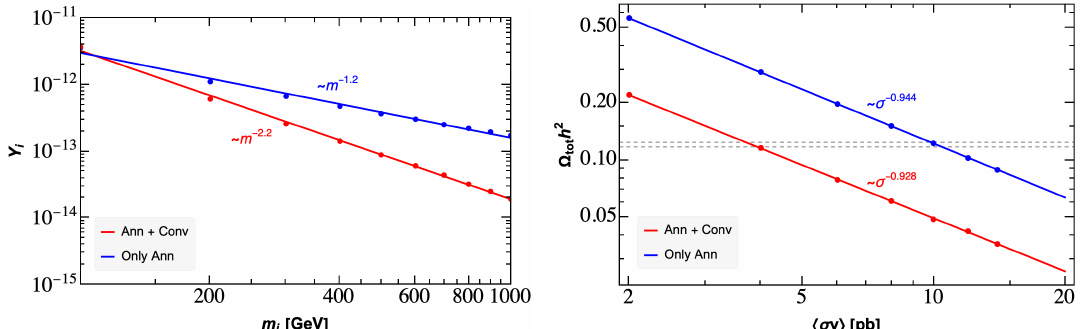
Figure 2 . Power-law fits for the yields (left panel) and total abundance (right panel) in the symmetric case for 10 DM particles with equal annihilation and conversion cross section, h σv i . Left panel: individual yields versus DM mass; we choose h σv i = 2 pb . Right panel: total abundance vs cross section; the grey dashed lines represent the 3 σ range for the observed DM relic abundance, Ω 2 = 0 . 12 ± 0 . 0012 DM h